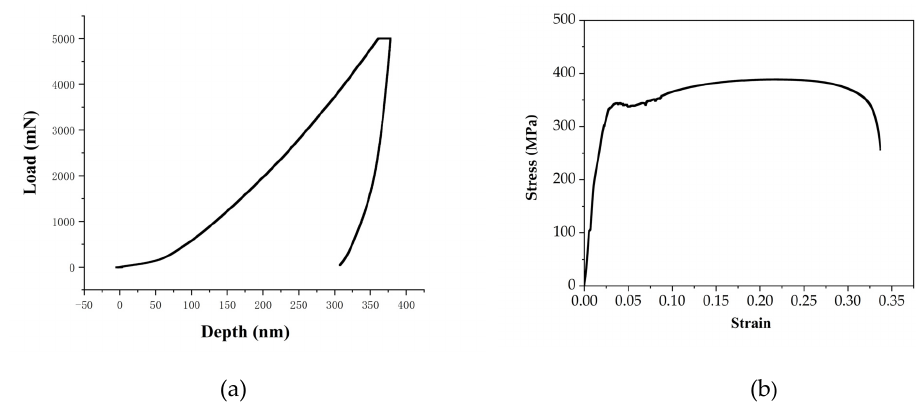
Figure 4. Test results: ( a ) Load-displacement curve. ( b ) Stress-strain curve. Table 1. Mechanical properties of AZM120.